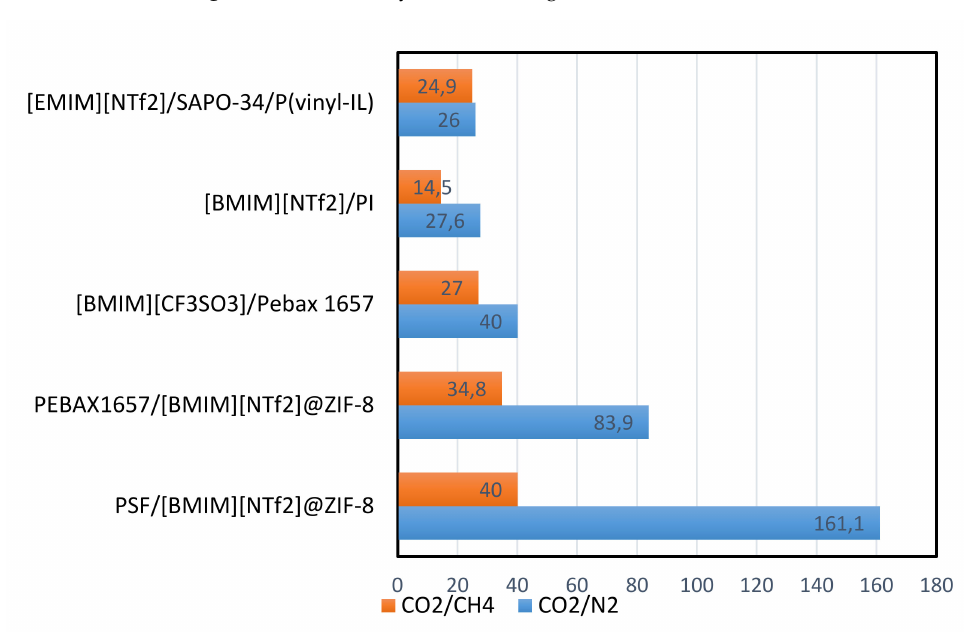
Figure 8. The selectivity of CO 2 / N 2 and CO 2 / CH 4 through several ILMMMs